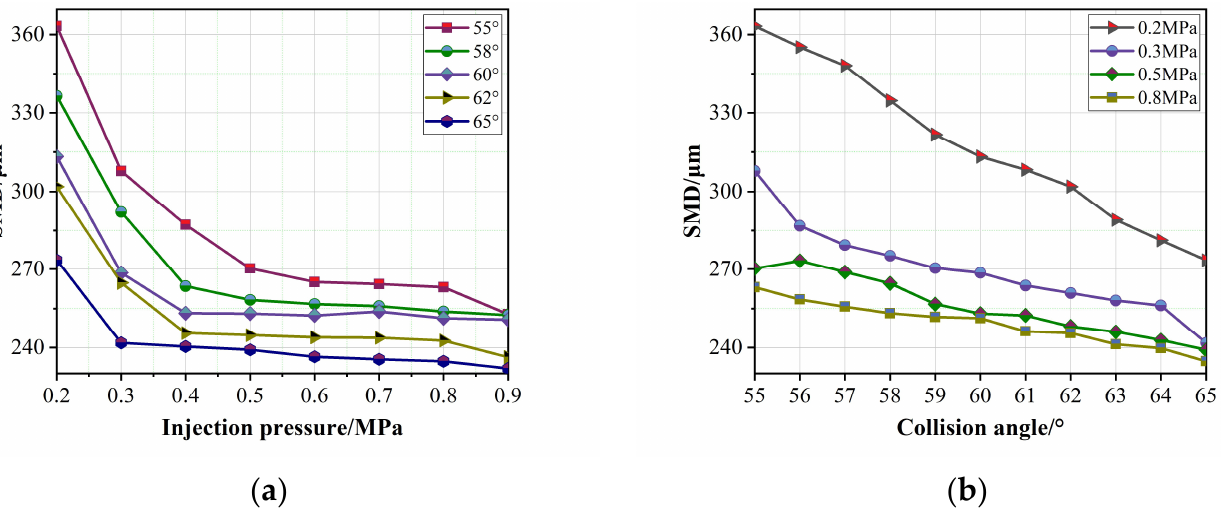
Figure 13. SMD curves of spray droplets with the collision angle and spray pressure: ( a ) for the collision angle with small deviation change, the curve of injection pressure, and the droplet SMD; ( b ) the variation curves of the collision angle and the droplet SMD under different injection pres- sures.